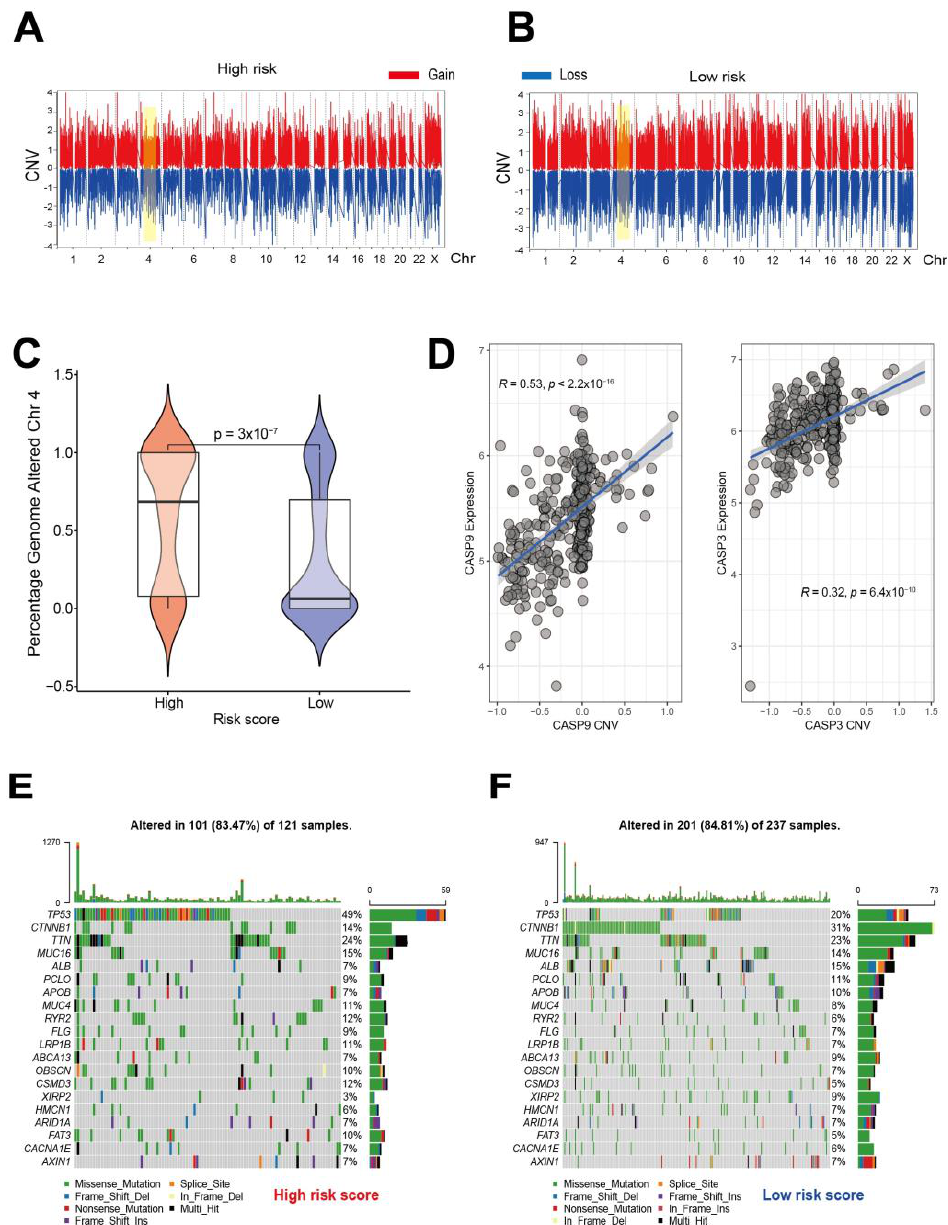
Figure 7. Comparison of the genetic characteristics of the two risk groups based on TCGA cohort. High ( A ) and low ( B ) pyroptosis score groups exhibited different CNV features across the whole chromosome. ( C ) The percentage frequency of genome alteration on chromosome 4 between the two score groups. ( D ) Correlation between CNV and gene expression in CASP9 and CASP3. Somatic mutation waterfall plot in ( E ) the high-risk, and ( F ) low-risk score groups. Each column represents an individual sample. The upper bar plot indicates TMB and the number on the right shows the mutation frequency. The right bar plot shows the proportion of each variant type.